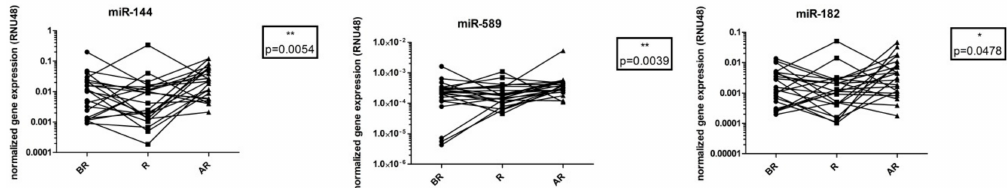
Figure 3. Validated miRNAs di ff erentially expressed during acute cellular rejection (ACR). The figure representsthevisualizationofrelativeexpressionlevelsofthreemiRNAs, miR-144, miR-589andmiR-182, respectively among the samples before rejection (BR), during rejection (R) and after rejection